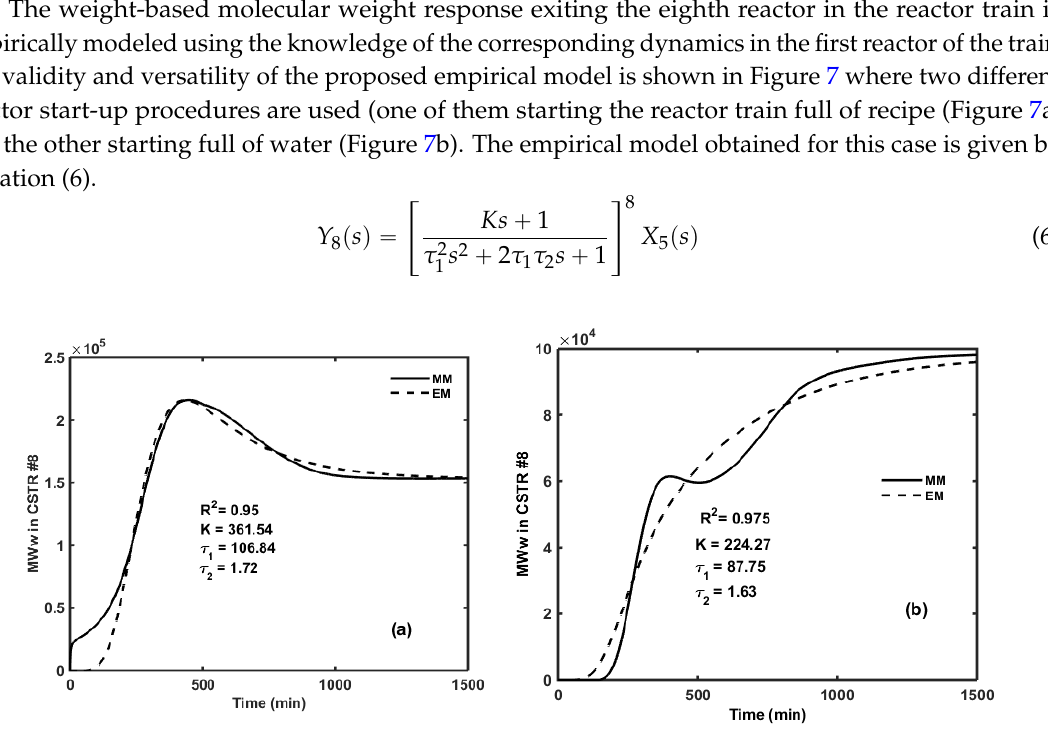
Figure 7. Comparison of the model validity for MW w at the exit of the eighth reactor using mechanistic model (MM) and empirical model (EM) for reactor train start-ups ( a ) full of recipe and ( b ) full of water.